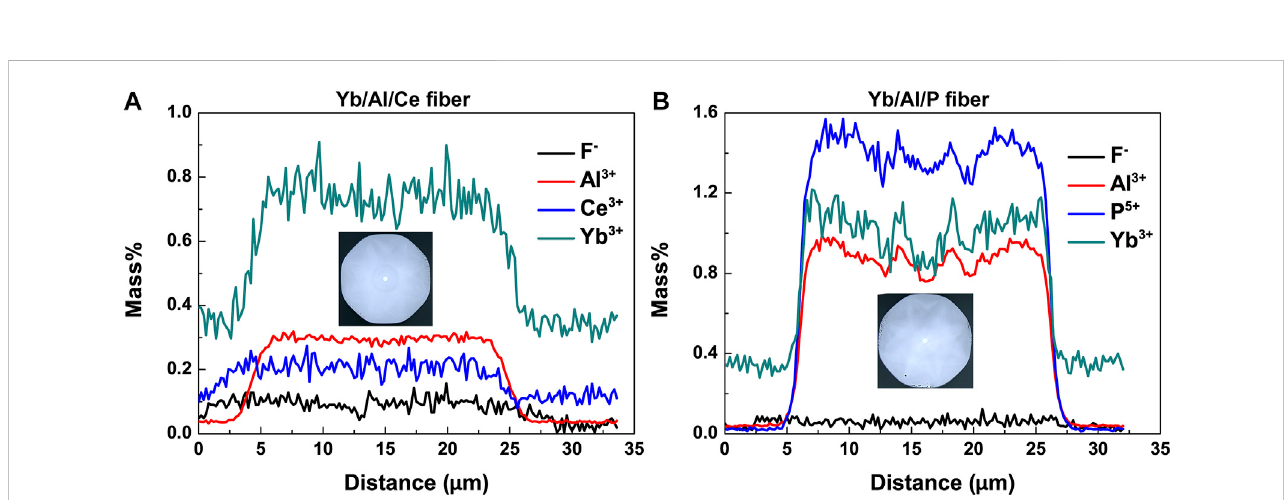
FIGURE 2 Theelementaldistributionof (A) Yb/Al/Ceco-dopedand (B) Yb/Al/Pco-doped fi bersmeasuredbyelectronprobemicroanalysis.(Insets:themicroscope images of the cross sections of two fi bers).